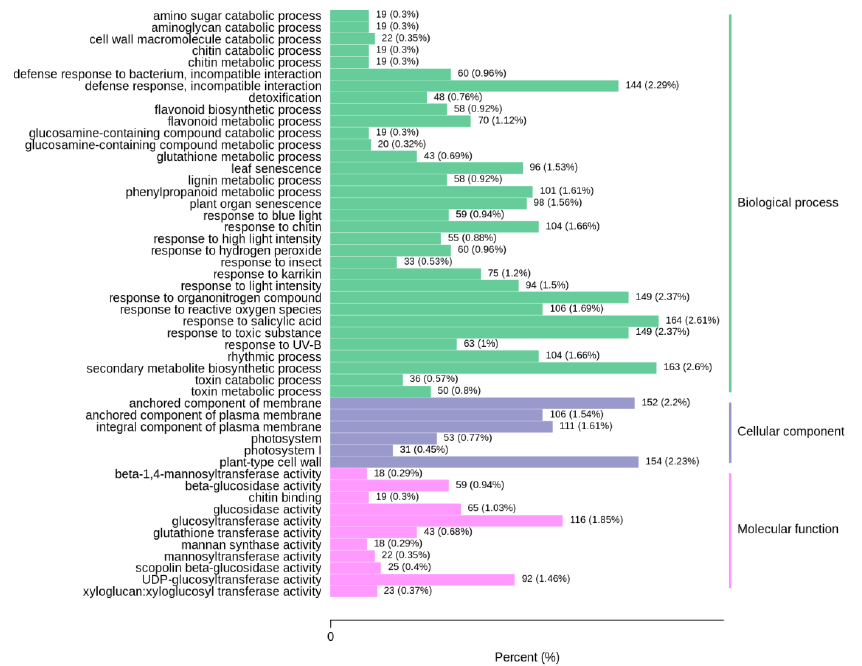
Figure 6. Differentially expressed genes divided into three different pathways based on gene ontol- ogy (GO).